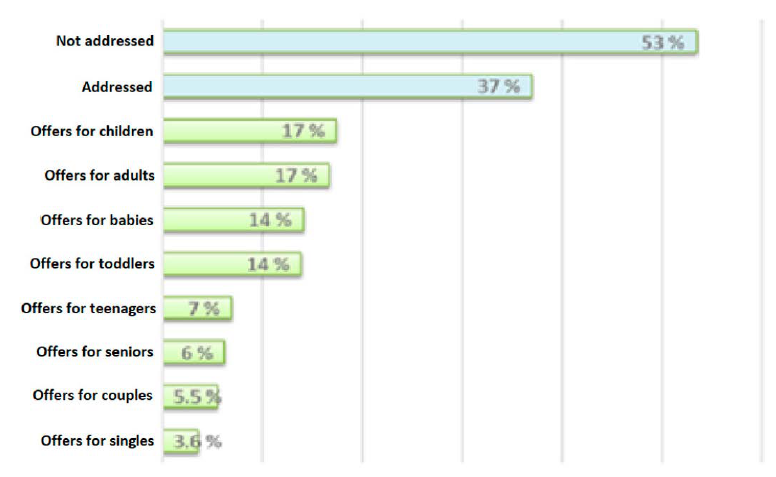
Figure 2. Attractiveness of family support offers to citizens (percentage data). (Source: Authors,